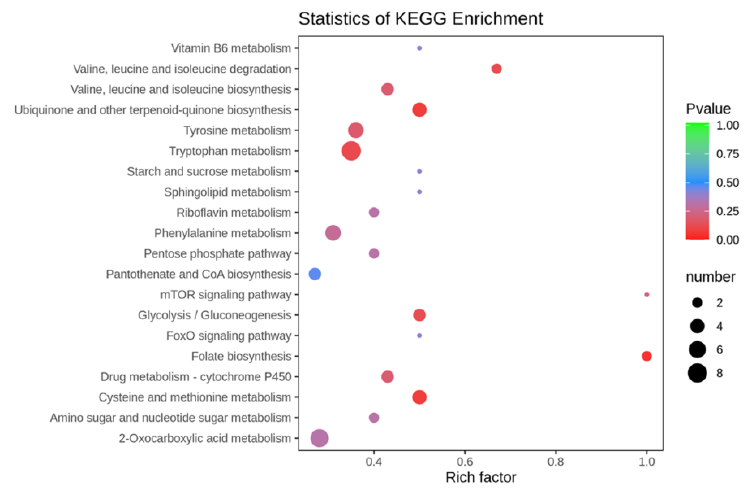
Figure 4. UV induction on the first 20 metabolic pathways of BSF, according to the Kyoto Encyclopedia of Genes and Genomes (KEGG) analysis. ( X -axis enrichment factors, Y -axis metabolic pathway representation).